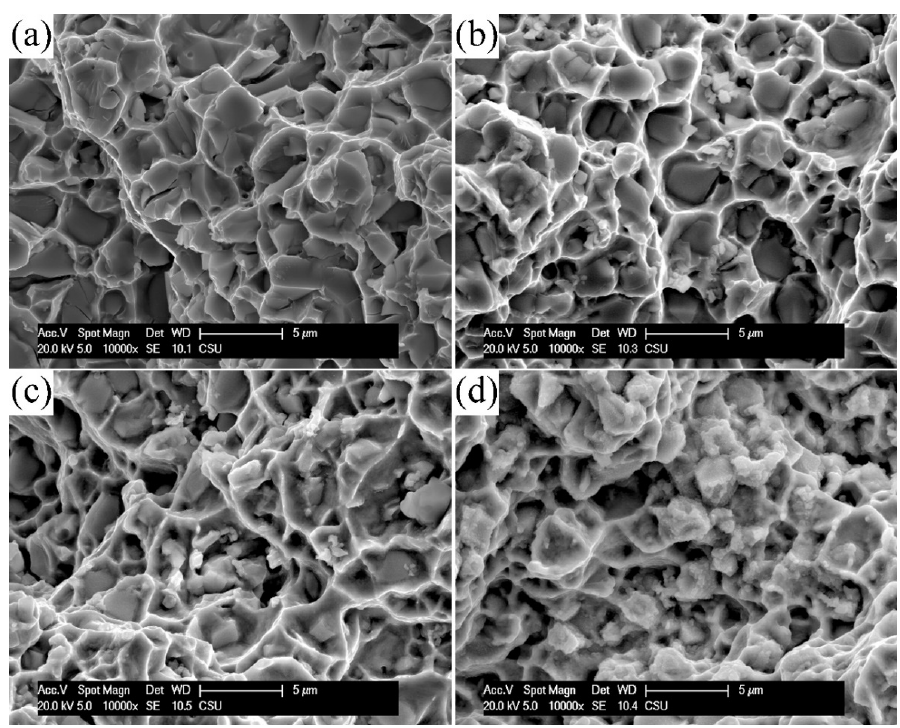
Figure 4. The fracture morphologies of the HEA after tensile tests at different temperatures. ( a ) Room temperature, ( b ) 700 °C, ( c ) 800 °C and ( d ) 900 °C.